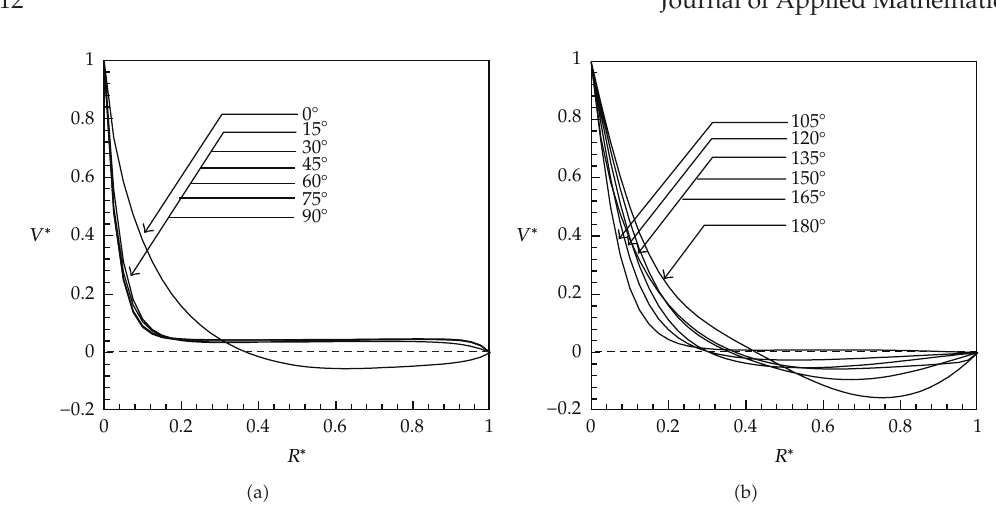
Figure 8: Angular velocity profiles subjected to two-quarter circular external magnetic fields at (cid:2) a (cid:3) 0 ◦ ≤ θ ≤ 90 ◦ and (cid:2) b (cid:3) 105 ◦ ≤ θ ≤ 180 ◦